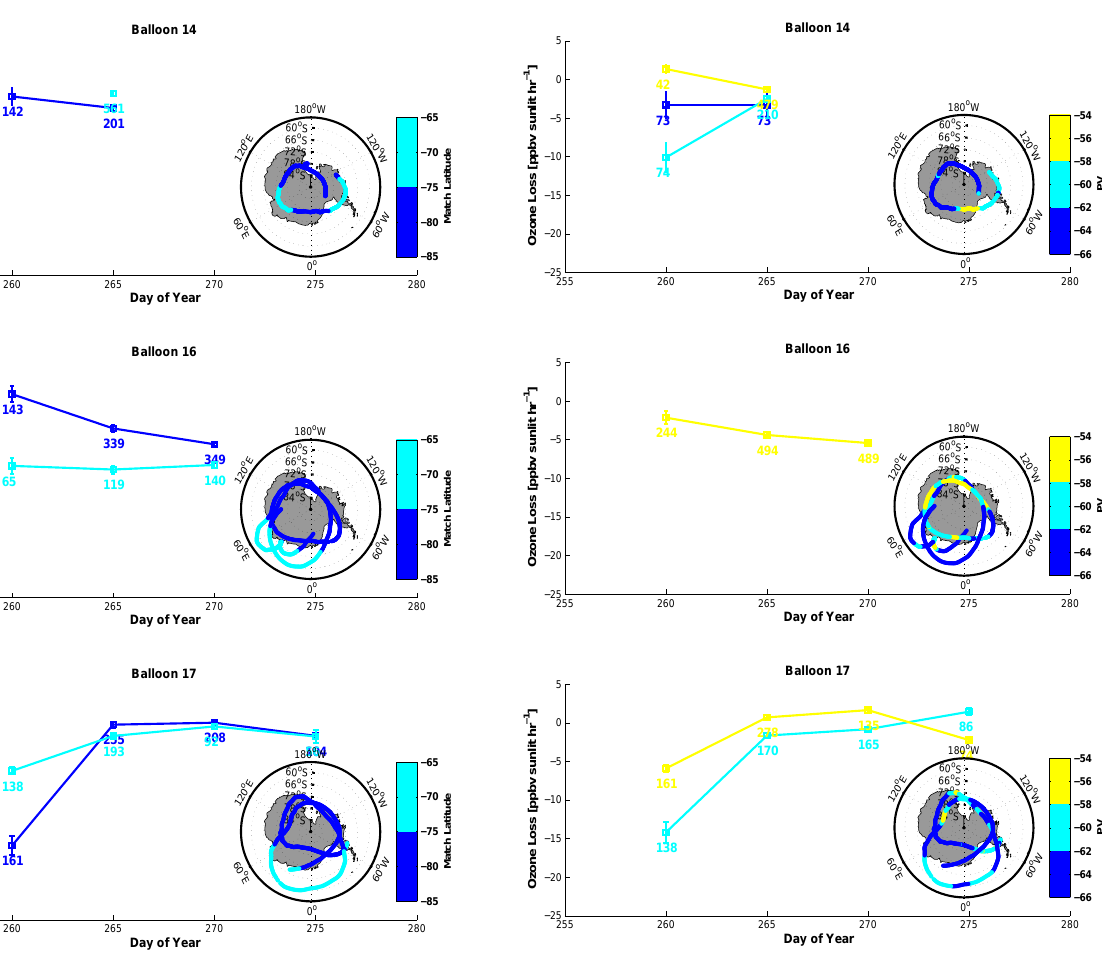
Figure 5. Ozone losses binned according to the mean latitude of the match.